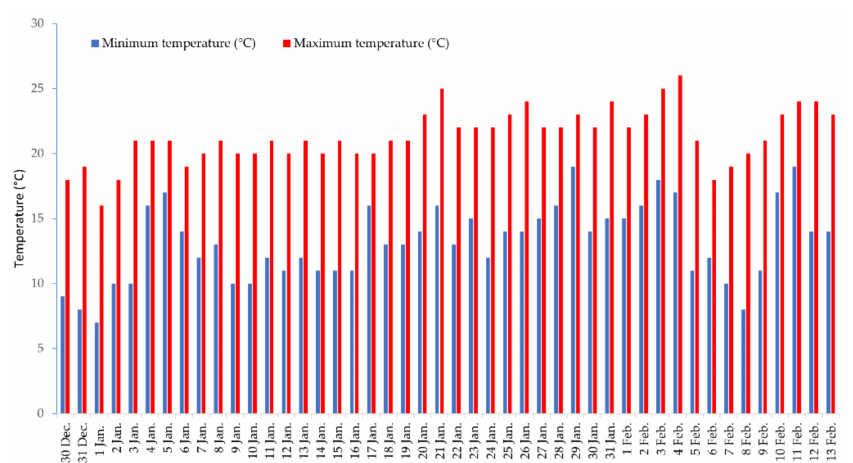
Figure 5. Maximum and minimum temperature registered daily from 30 December to 13 February at the experimental station (latitude 38.12 ◦ N, longitude 13.36 ◦ E, altitude 65 m). On 30 December 2020, plug plants of spinach ( Spinacia oleracea L.) Spargo F 1 (Fratelli Ingegnoli, Milan, Italy), were transplanted at the 4–5 true leaves stage with a plant